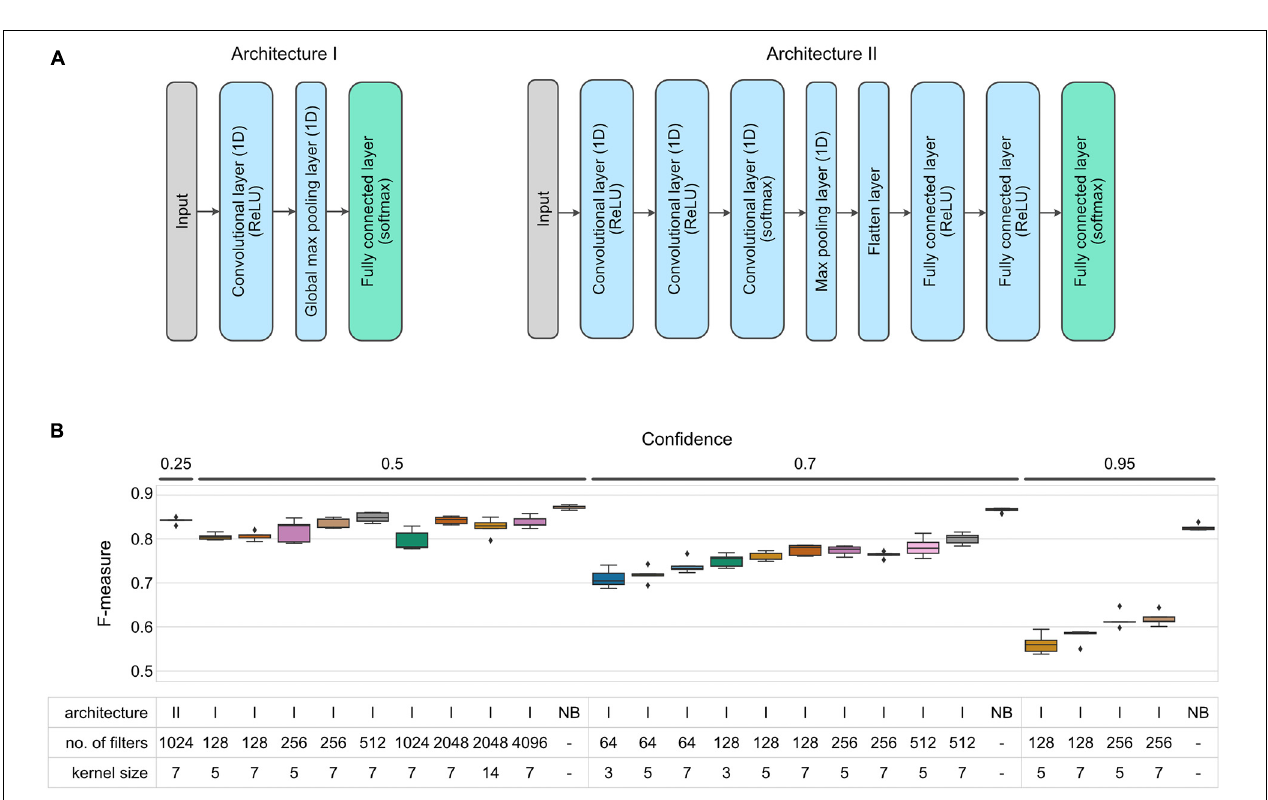
FIGURE 1 | F-measure accuracy performance of RF and NB classifiers. Box-and-whisker plots indicate the median and quartile distributions of F-measures for each classifier and configuration, across 5-fold of CV. RF classifier configurations were tested via a grid search across the hyperparameters listed in the subset table. NB classifiers do not have equivalent parameters, and hence only NB is listed in the table beneath bars representing NB classifiers. Both RF and NB classifiers were tested at multiple confidence levels. None of the tested parameter sets outperformed the NBC at any of the confidence levels (Wilcoxon signed-rank test p < 0.05).